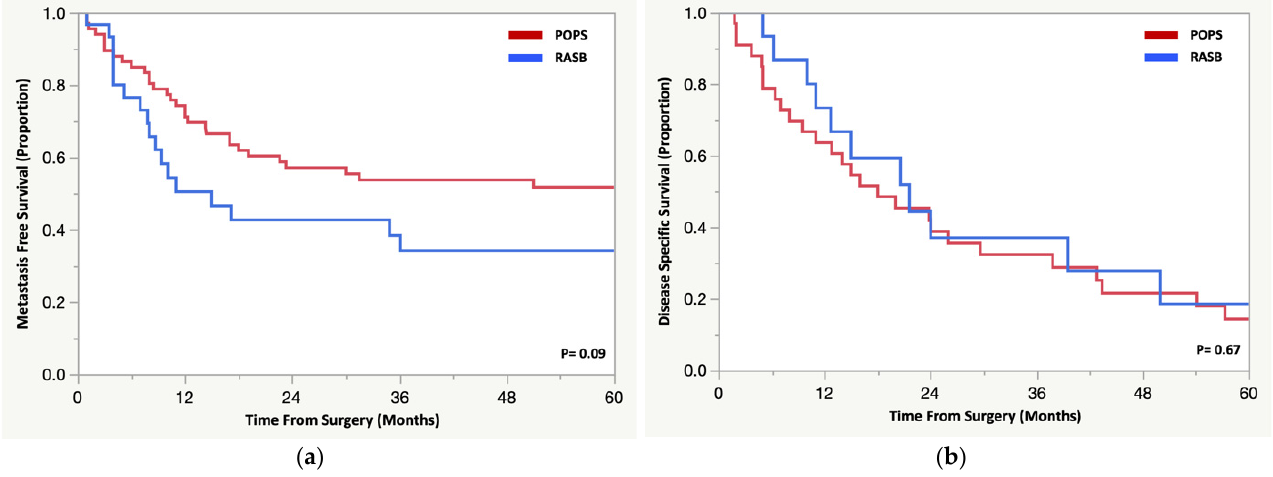
comparing patients who developed a metastasis between groups, DSS was poor, with no difference between patients with RASB compared to POPS (19% vs. 14% at 5 years, p = 0.67) (Figure 4B).